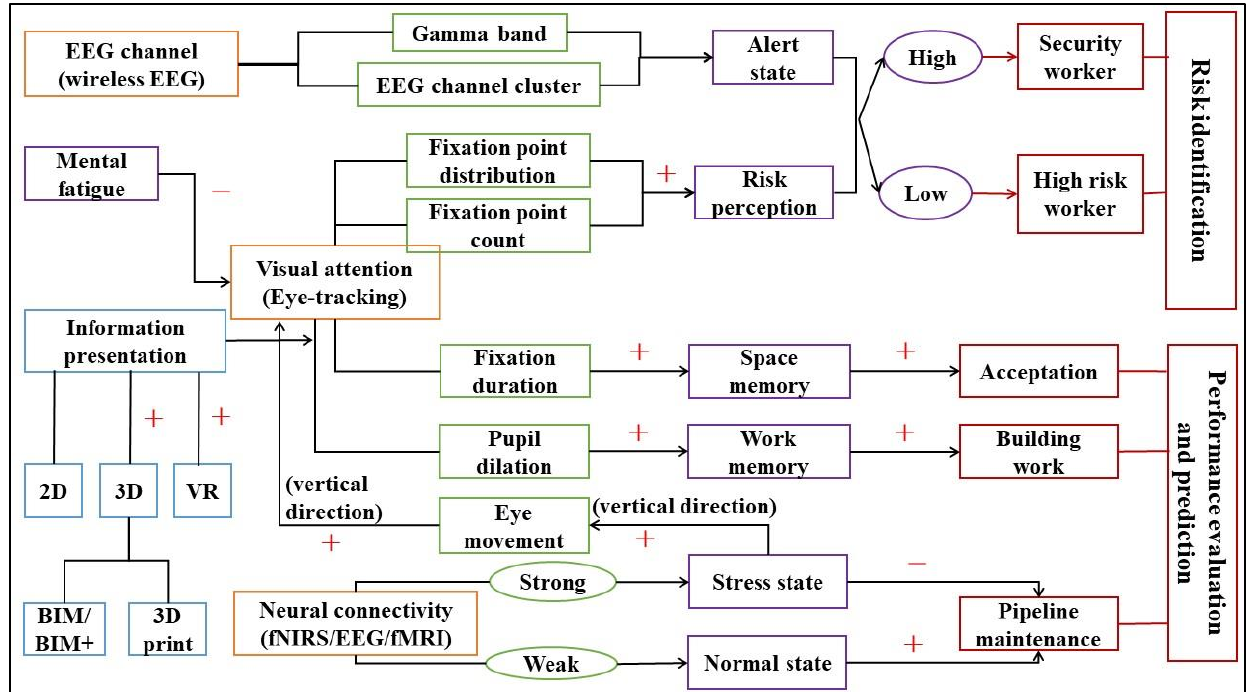
Figure 6. Complex behavioral associations. “+” indicates enhancing or positive promotion, “−” indicates weakening or negative inhibition, “unsigned” paths represent correlation only.